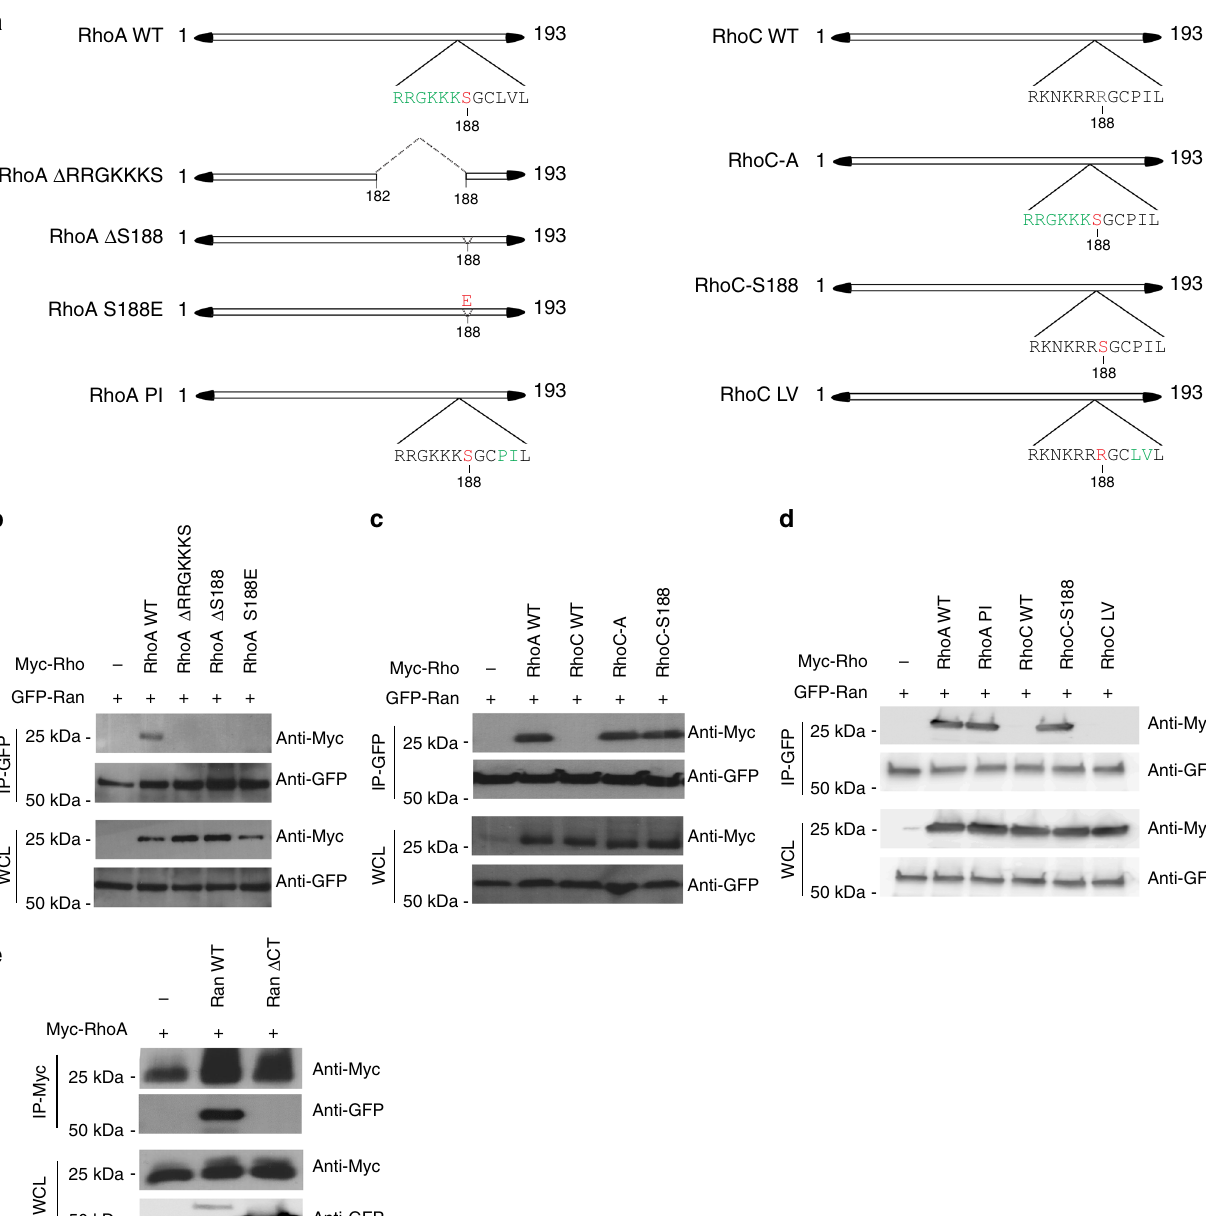
Fig. 3 The serine 188 of RhoA is required for RhoA interaction with the DEDDDL polyacid domain of Ran. a Schematic of RhoA and RhoC mutant constructs. b TOV-112D cells were co-transfected with 2xGFP-Ran (WT) and either control, Myc-RhoA (WT), Myc-RhoA ( Δ RRGKKKS), Myc-RhoA ( Δ S188), or Myc-RhoA (S188E) followed by an immunoprecipitation (IP) using an anti-GFP antibody and western blotted as shown. c TOV-112D cells were co-transfected with 2xGFP-Ran (WT) and either control, Myc-RhoA (WT), Myc-RhoC (WT), Myc-RhoC-A, or Myc-RhoC-S188 followed by an IP with an anti-GFP antibody and western blotted as shown. d TOV-112D cells were co-transfected with 2xGFP-Ran (WT) and either control, Myc-RhoA (WT), Myc- RhoA (PI), Myc-RhoC (WT), Myc-RhoC-S188, or Myc-RhoC (LV) followed by an IP with an anti-GFP antibody and western blotted as shown. e TOV-112D cells were co-transfected with Myc-RhoA (WT) or 2xGFP-Ran (WT) or EGFP-Ran Δ CT (Ran without DEDDDL motif) followed by an IP with an anti-Myc antibody and western blotted as